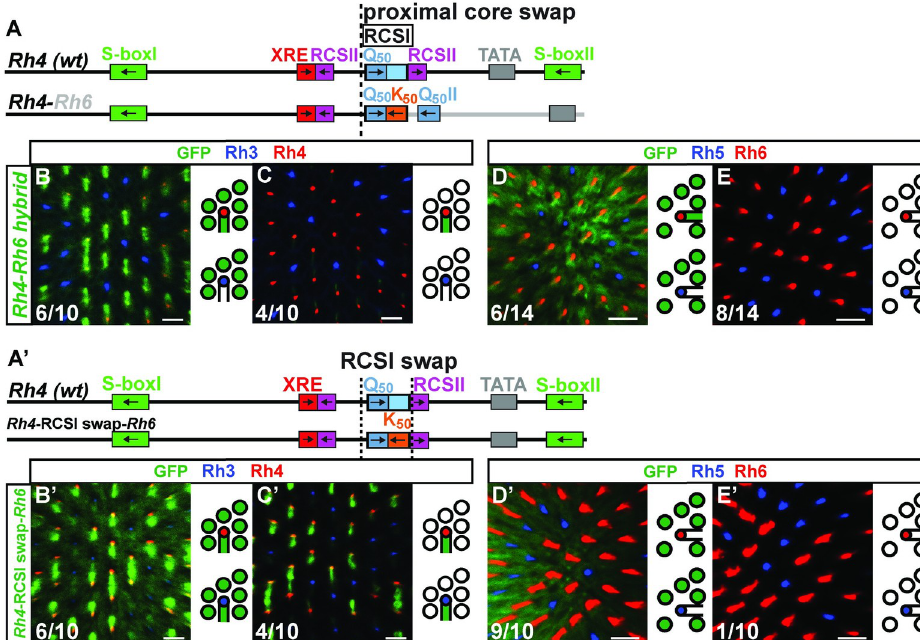
Fig 4. Incompatibility of distal Rh4 and proximal Rh6 . (A) Schematic comparison of the wild type Rh4 promoter and the Rh4-Rh6 hybrid. The dotted vertical line indicates the break/fusion point of the hybrid immediately upstream of the RCSI motif that is found in a similar position in all Rhs . (B)—(C) and (B’)—(C’) Hybrid and RCSI swap driving GFP reporter expression (green) in the R7 layer. Rh3 (blue) labels pR7s and Rh4 (red) labels yR7s. (D)—(E) and (D’)— (E’) Hybrid and RCSI swap driving GFP reporter expression (green) in the R8 layer. Rh5 (blue) labels pR8s and Rh6 (red) labels yR8s. (B) and (C) The Rh4-Rh6 hybrid drives variable reporter expression. 6/10 retinas exhibit strong GFP expression in yR7s and R1-R6, 4/10 retinas show weak GFP expression only in yR7s. N = 10 retinas and n = 841 R7s. (D) and (E) The Rh4-Rh6 hybrid drives variable reporter expression. 6/14 retinas show strong GFP expression in yR8s and R1-R6, 8/14 retinas show no detectable GFP expression in R8s or R1-R6. N = 14 retinas, n = 902 R8s and 5,412 R1-R6 PRs. (A’) Schematic comparison of the wild type Rh4 promoter and the specific RCSI swap with the Rh6 RCSI (indicated by the dotted vertical lines). Note the shared Q 50 motif in the RCSI. (B’) and (C’) The swap of the Rh4 RCSI with the Rh6 RCSI in the Rh4 promoter context drives variable GFP reporter expression. 6/10 retinas show strong GFP expression in both R7 subtypes and R1-R6, 4/10 retinas show GFP expression in both R7 subtypes but not R1-R6. N = 10 retinas and n = 646 R7s. (D’) and (E’) The swap of the Rh4 RCSI with the Rh6 RCSI in the Rh4 promoter context drives variable GFP reporter expression. 9/10 retinas show strong GFP expression in R1-R6, 1/10 retinas show no detectable GFP expression in R8 or R1-R6. N = 10 retinas, n = 642 R8s and 3,852 R1-R6 PRs. Scale bars, 10 μ m.